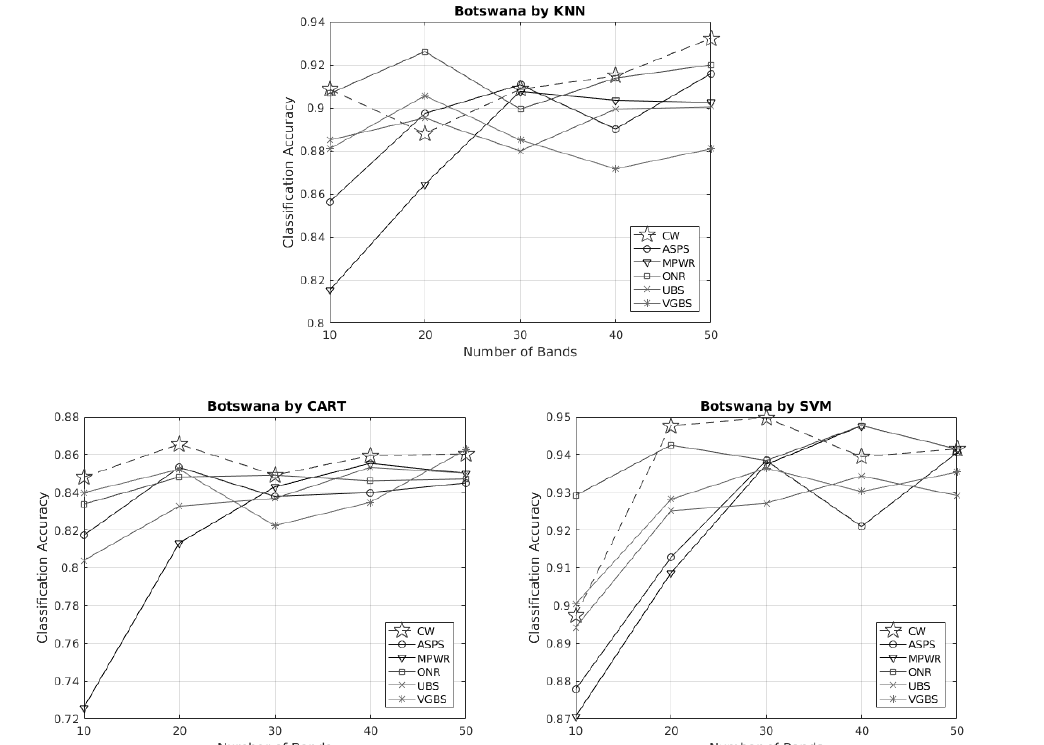
Figure 4. Overall Accuracies for Botswana Image according to KNN, CART, and SVM